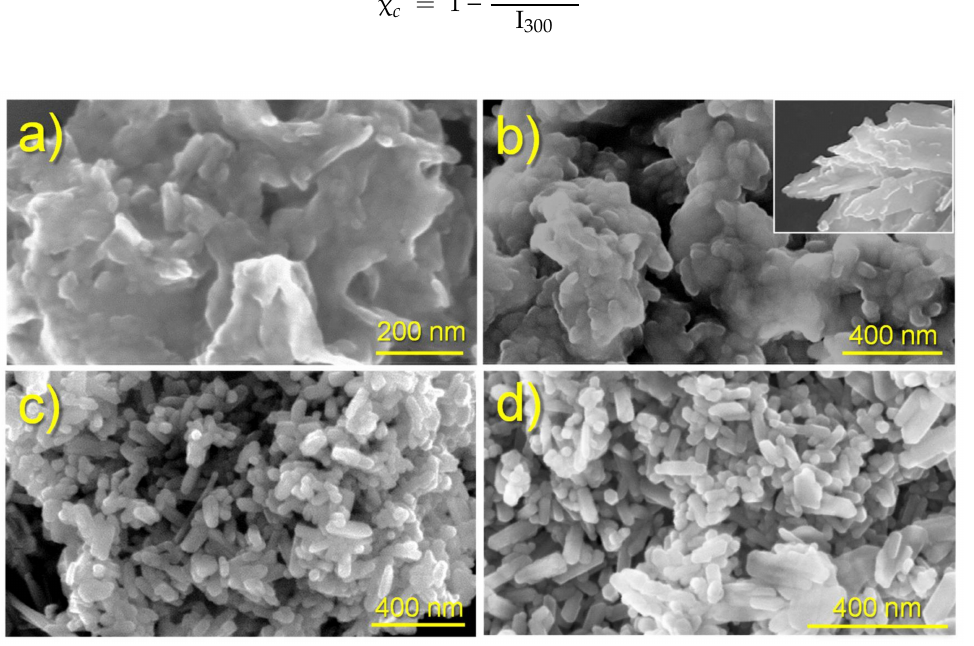
Figure 2. SEM images showing the morphology of nanoparticles of: ( a ) ACP, ( b ) ACP loaded with CAM (ACP-CAM), ( c ) cHAp and ( d ) cHAp loaded with CAM (cHAp-CAM). Inset of ( b ) shows typical CAM crystals.